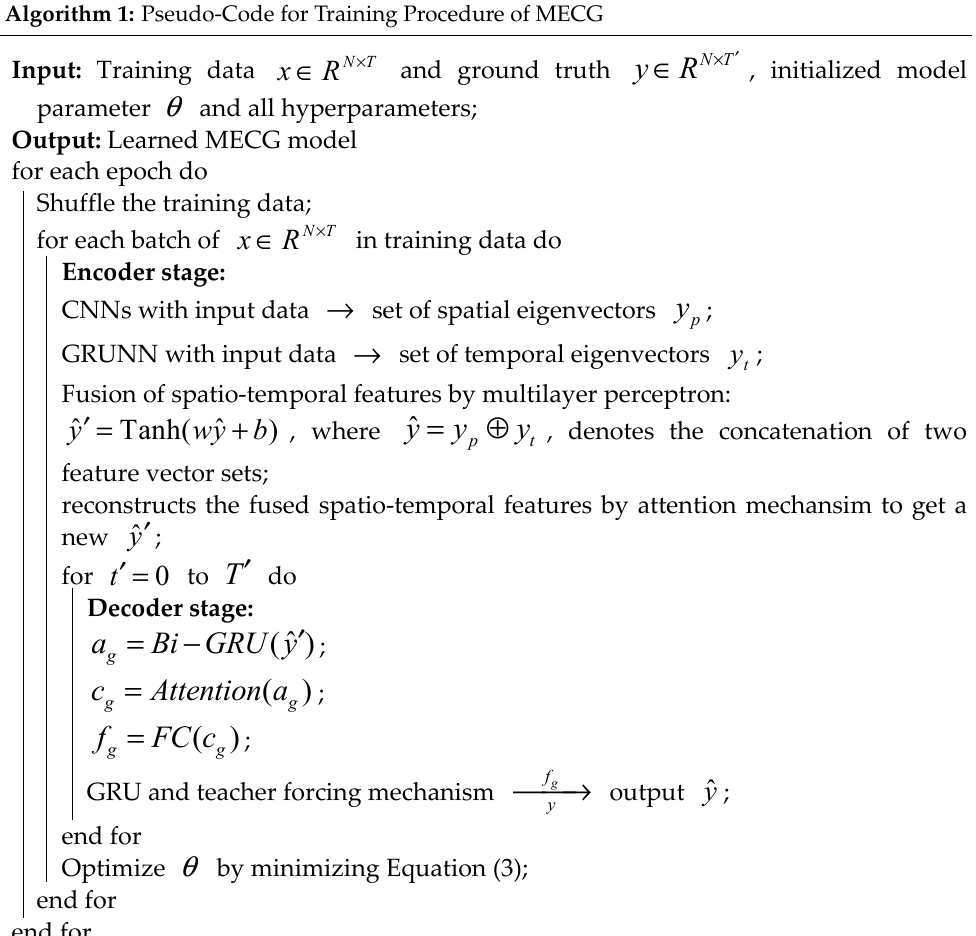
Figure 5. Decoder structure. Algorithm 1: Pseudo-Code for Training Procedure of MECG Algorithm 1: Pseudo-Code for Training Procedure of